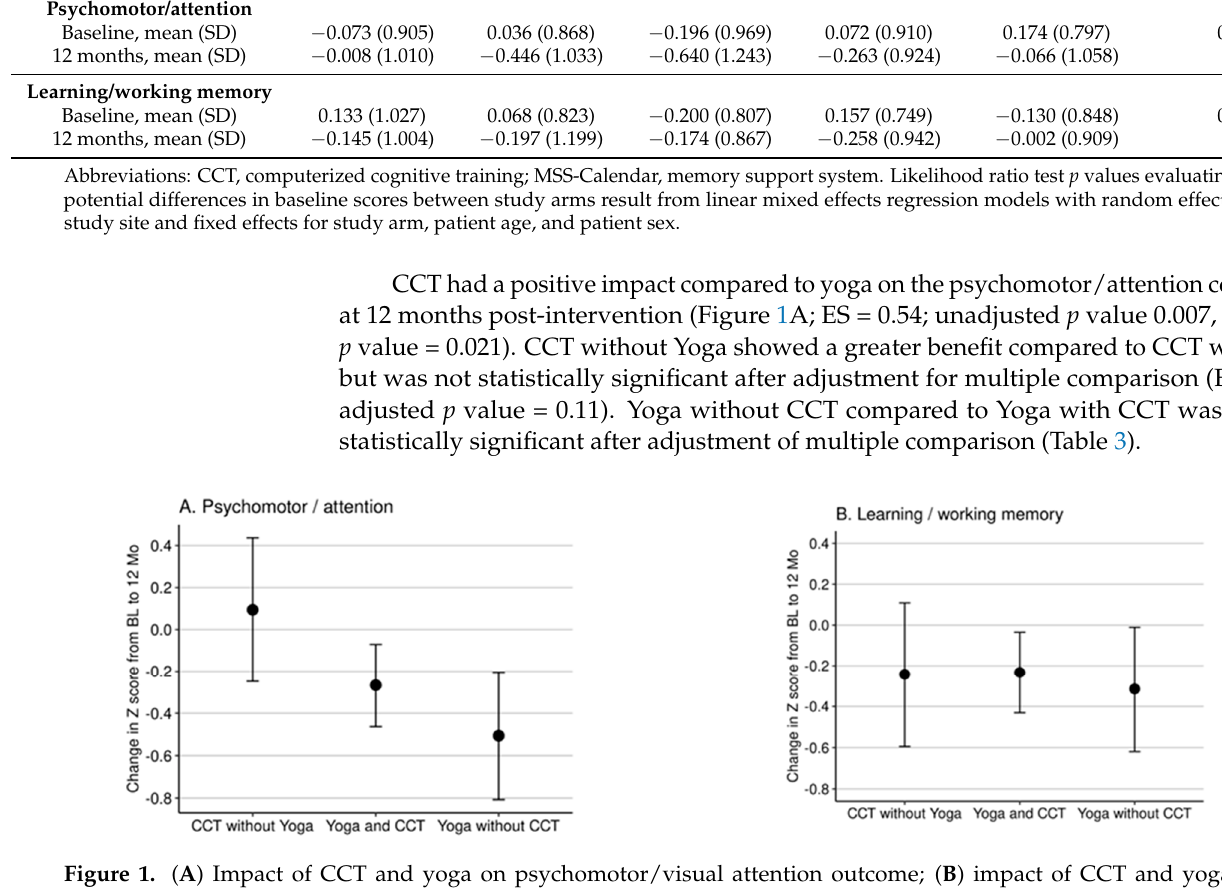
Figure 1. ( A ) Impact of CCT and yoga on psychomotor/visual attention outcome; ( B ) impact of CCT and yoga on learning/working memory outcome.